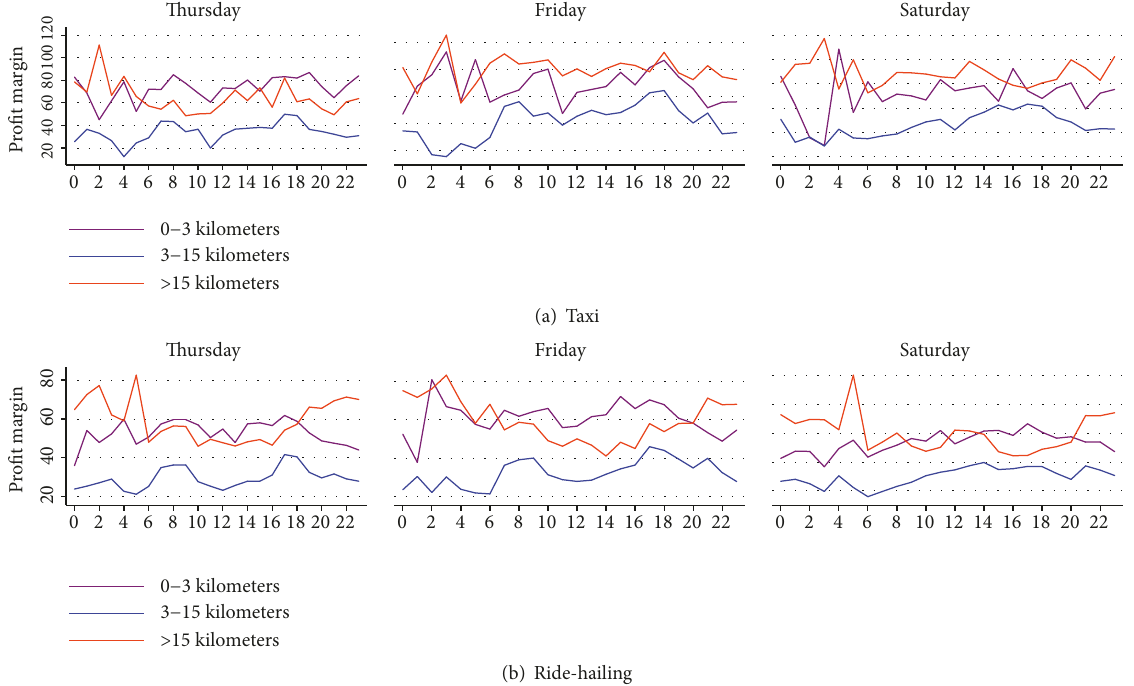
Figure 6: The daily trend of HQC in different trip lengths. We categorize all the trips into three classes, namely, short trips (i.e., the trips that are less than 3 km), long trips (i.e., the trips that are more than 15 km), and intermediate trips (i.e., the trips that are more than 3 km and less than 15